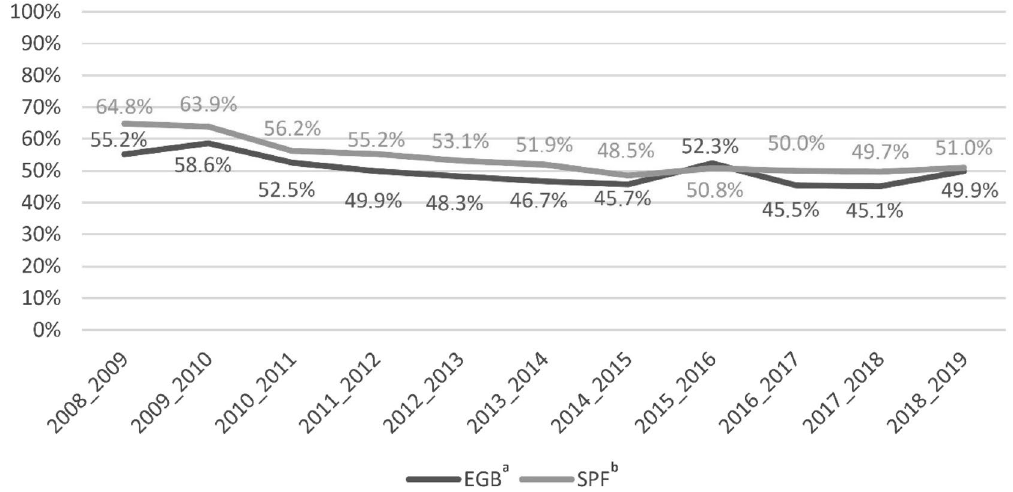
Figure 1. Influenza vaccination coverage in the French population over 65 years old in EGB database and French Public Health data